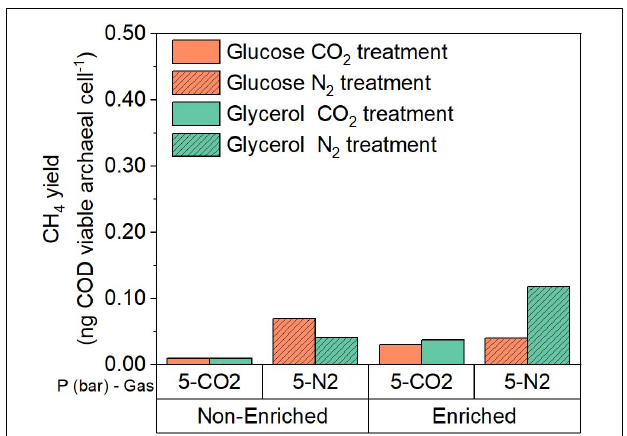
FIGURE 8 | CH 4 yield normalized by the viable archaeal cell density at the end of the experiment for the glucose and glycerol conversion experiments at elevated pCO 2 using original inoculum and evolved inoculum at 5 bar. Pressure corresponds to initial values before equilibrium. Nitrogen controls (5 bar) are included as a